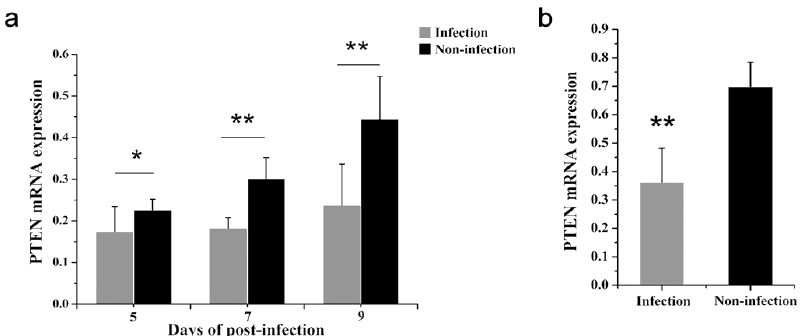
Figure 5. PTEN was down-regulated in both MG- infected chicken embryo lung tissues and DF-1 cells. ( a ) The relative mRNA level of PTEN in MG infected chicken embryo lungs. Total RNA were extracted using TRNzol Universal from frozen infected chicken embryos lungs on days 5, 7, and 9 post-infection (equivalent to days 14, 16, and 18 of eggs hatching). Then, the relative mRNA level of PTEN in MG - infected lungs was detected by RT-qPCR. ( b ) The relative mRNA level of PTEN in MG- infected DF-1 cells. DF-1 cells cultured in six-well culture dishes were incubated with 200 μL MG (1 × 10 10 CCU/mL) for 24 h. Then, the cells were harvested. Total RNA of MG -infected DF-1 cells were extracted using TRNzol Universal. PTEN expression in infected DF-1 cells were detected by RT-qPCR. GAPDH was served as an internal control. Each experiment group contained at least three duplicates. Each duplicate was measured at least three times. Values are expressed as mean ± SD. Marked differences are expressed as * p < 0.05, ** p < 0.01.